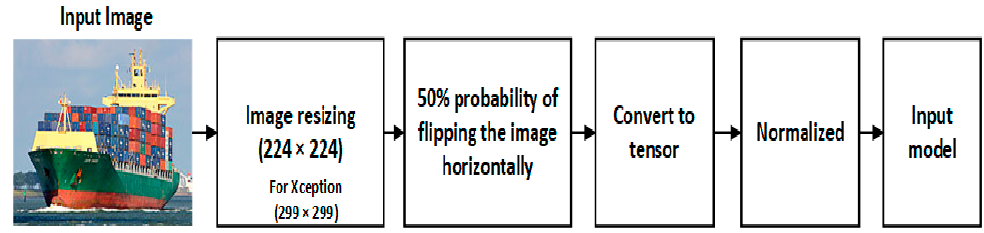
Figure 3. Pre-processing process for input image.